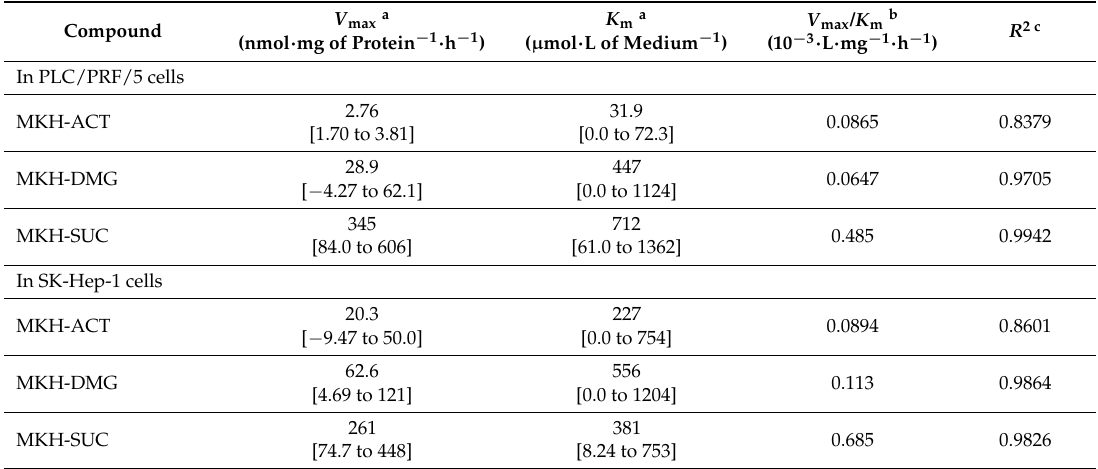
Figure 3. Kinetic plots for the uptake of MKH-ester derivatives in HCC cells. ( A ) PLC/PRF/5 and ( B ) SK-Hep-1 cells were treated with various concentrations of MKH-ACT, MKH-DMG or MKH-SUC. The curves represent the best fit of the Michaelis–Menten equation to the data. Each point represents the mean ± SD from duplicate experiments. Table 1. Kinetic parameters for the uptake of MKH-esters in hepatocellular carcinoma (HCC) cells treated with MKH-ACT, MKH-DMG or